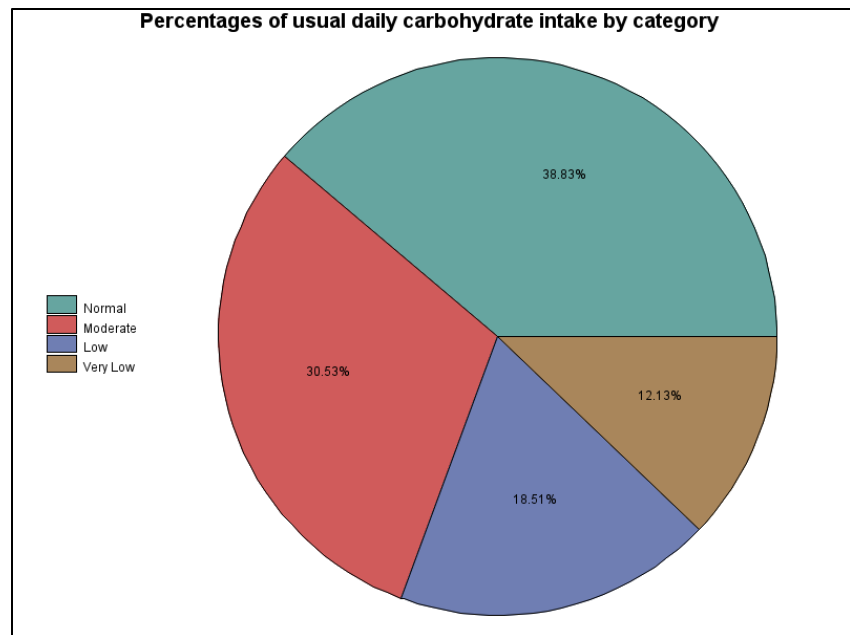
Figure 10. Percentages of usual daily carbohydrate intake by category.